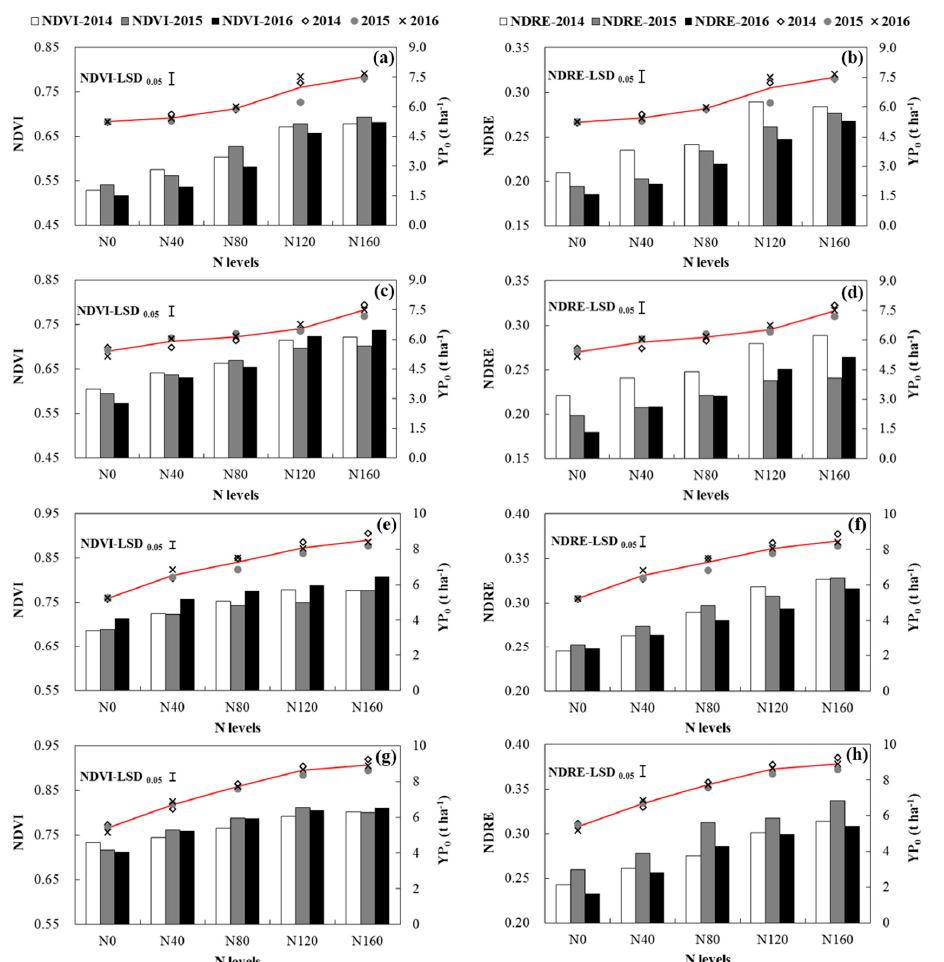
Figure 3. Rice yield without additional topdressing N application (YP 0 ) or NDVI (a; c; e; g) and YP 0 or NDRE (b; d; f; h) obtained by RapidSCAN at the stem elongation (a; b; c; d) and heading (e; f; g; h) stages as affected by different N rates for Longjing 31 (a; b; e; f) and Longjing 21 (c; d; g; h) in 2014-2016, respectively. Different color bars represent the value of NDVI or NDRE in different years. Different dots represent YP 0 in different years. The red curves were the curves of rice yield potential without additional topdressing N application (YP 0 ). Vertical bars represent the LSD value ( p = 0.05) among different N levels.